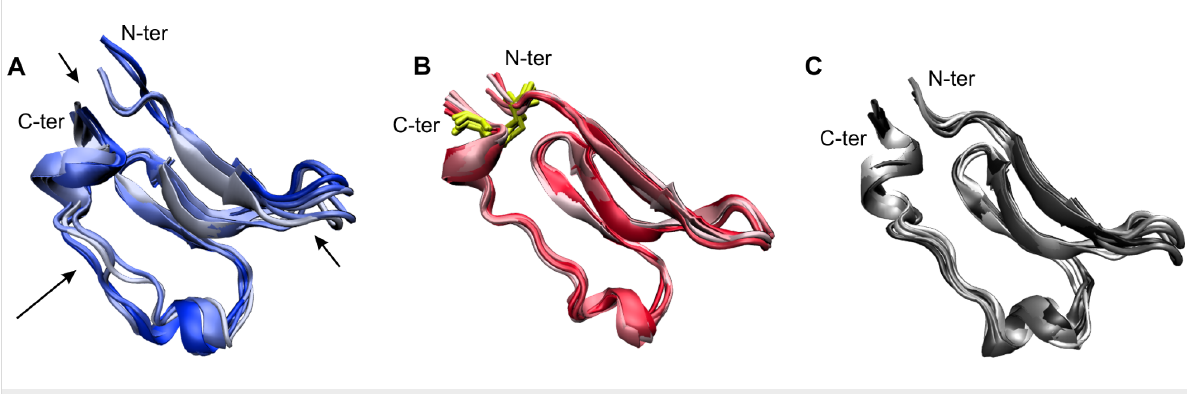
Figure 6: Structural presentation of peptide motions in the gp120-bound state during the MD simulation. (A) CD4-M1, (B) CD4-M2, (C) respective sequence stretch of CD4 (the remaining part of CD4 has been omitted for simplicity in this plot). The disulfide bridge that fixes N- and C-termini in CD4-M2 is represented by yellow sections. Arrows indicate regions in CD4-M1 that show enhanced fluctuation during simulation, namely the N- and C-termini, the CC’-loop and the stretch between the short 3 10 -helixes upstream of the